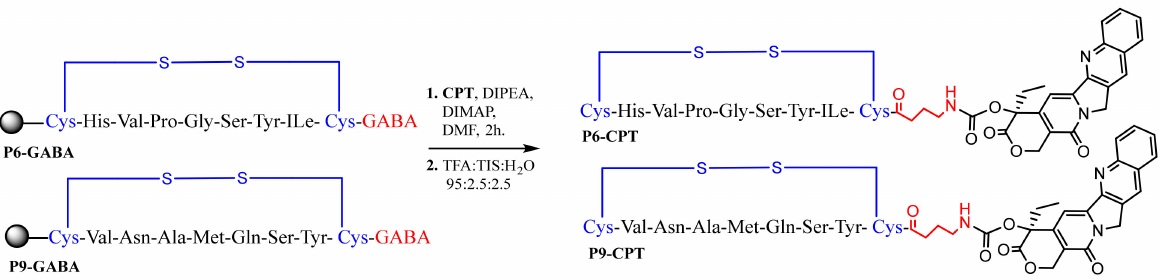
Figure 7. Synthesis of the P6-CPT and P9-CPT